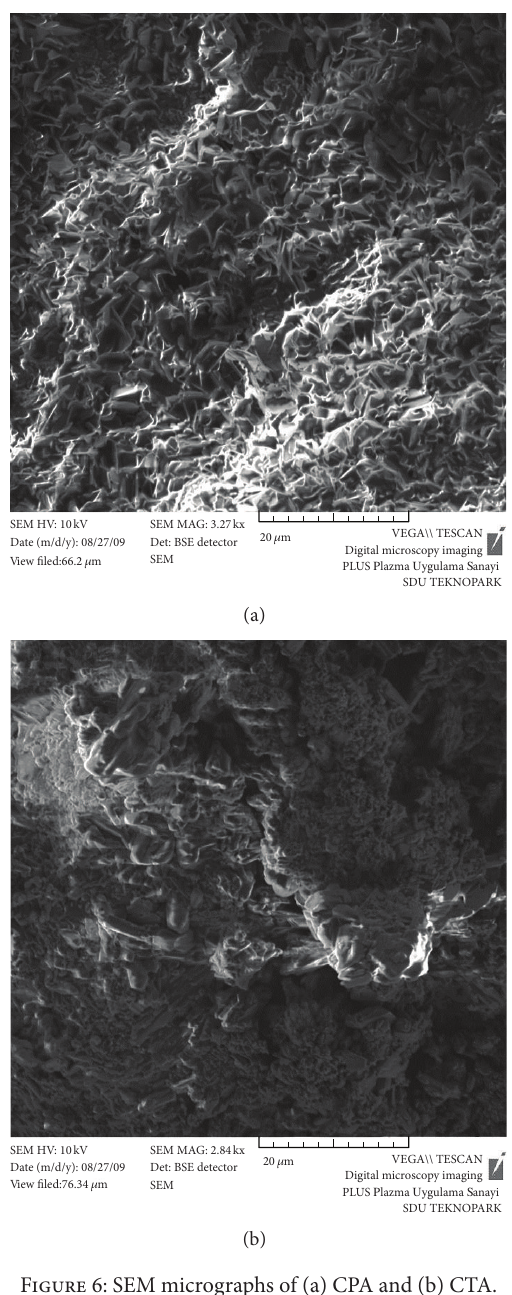
F 6: SEM micrographs of (a) CPA and (b)